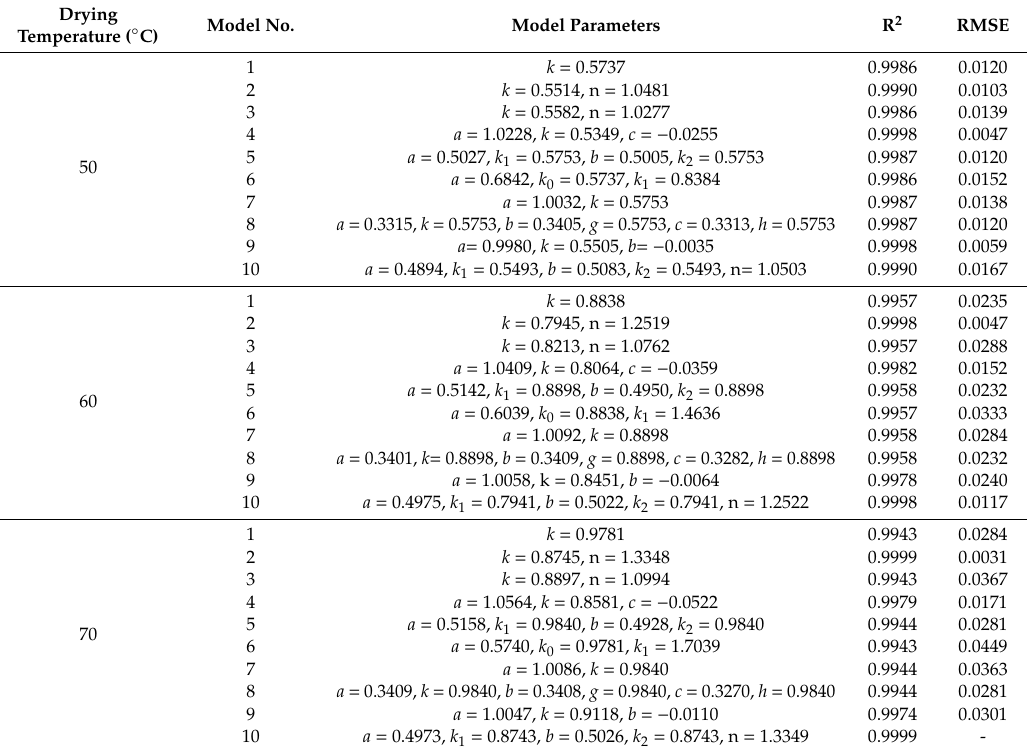
Table 6. Statistical evaluation of the mathematical drying models for persimmon samples of 5 mm thickness for